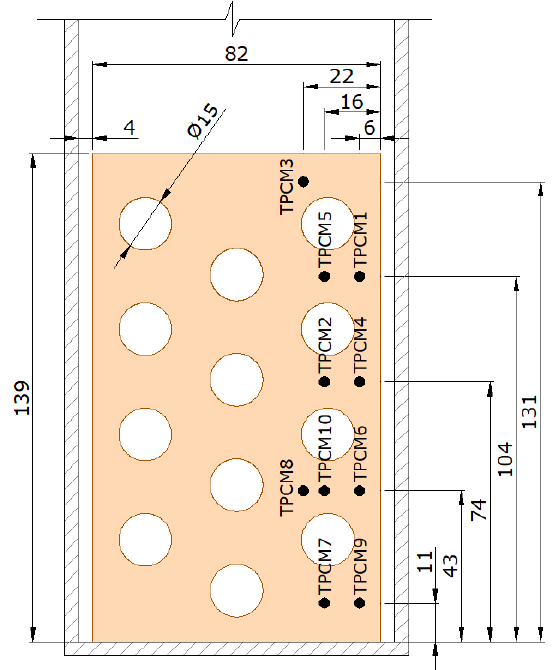
Figure 4. Positions of the temperature measuring points in the cross-section of the HX. The positions of temperature sensors in the cross-section of HX are depicted in Figure